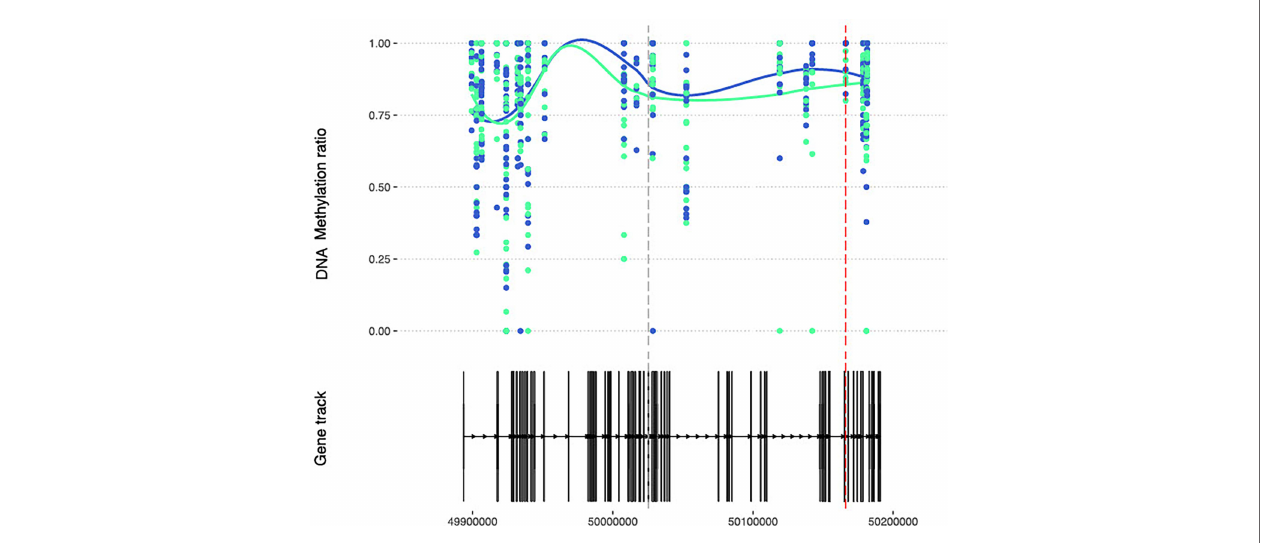
FIGURE 4 | DNA methylation at CpGs overlapping the RA susceptible WDFY4 gene. DNA methylation at CpGs (N=41) overlapping the WDFY4 gene. Smoothed lines show mean DNA methylation values for the two patient sampling time points (baseline methylation values in green and follow-up values in blue). The red dotted vertical line marks the position of the DMP, and the grey dotted line marks the RA risk SNP. RA, Rheumatoid arthritis; WDFY4, WD Repeat and FYVE Domain- Containing Protein 4; SNP, Single nucleotide polymorphism.